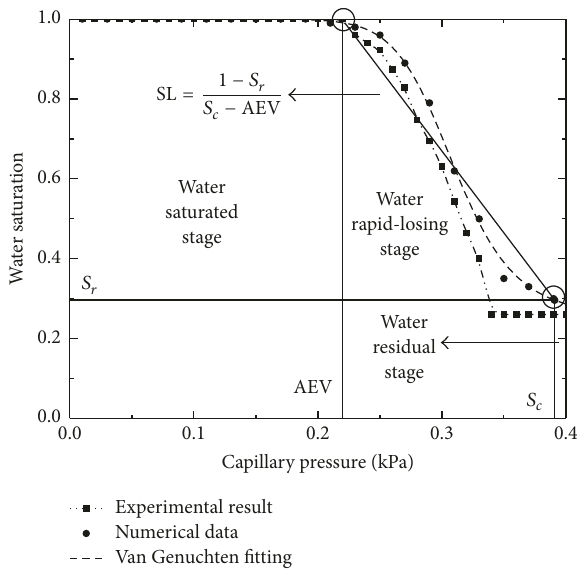
Figure 7: Comparison of the numerical data and experimental